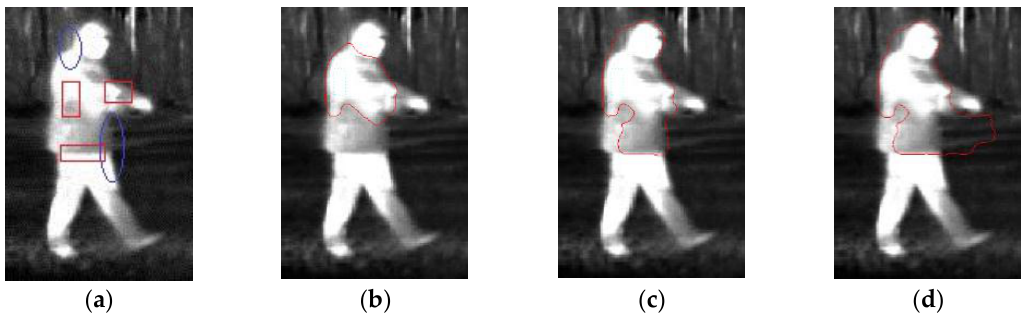
Figure 1. DRLSE segmentation results. ( a ) Original image; ( b ) 𝛼 = 2.5 ; ( c ) 𝛼 = 2.7 ; ( d ) 𝛼 = 3 .